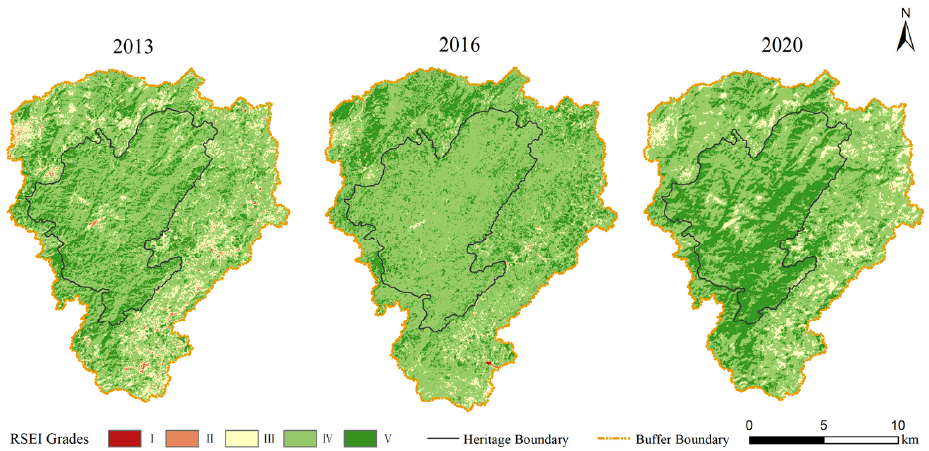
Figure 3. Spatial and temporal evolution of the RSEI grades at the Shibing Karst.